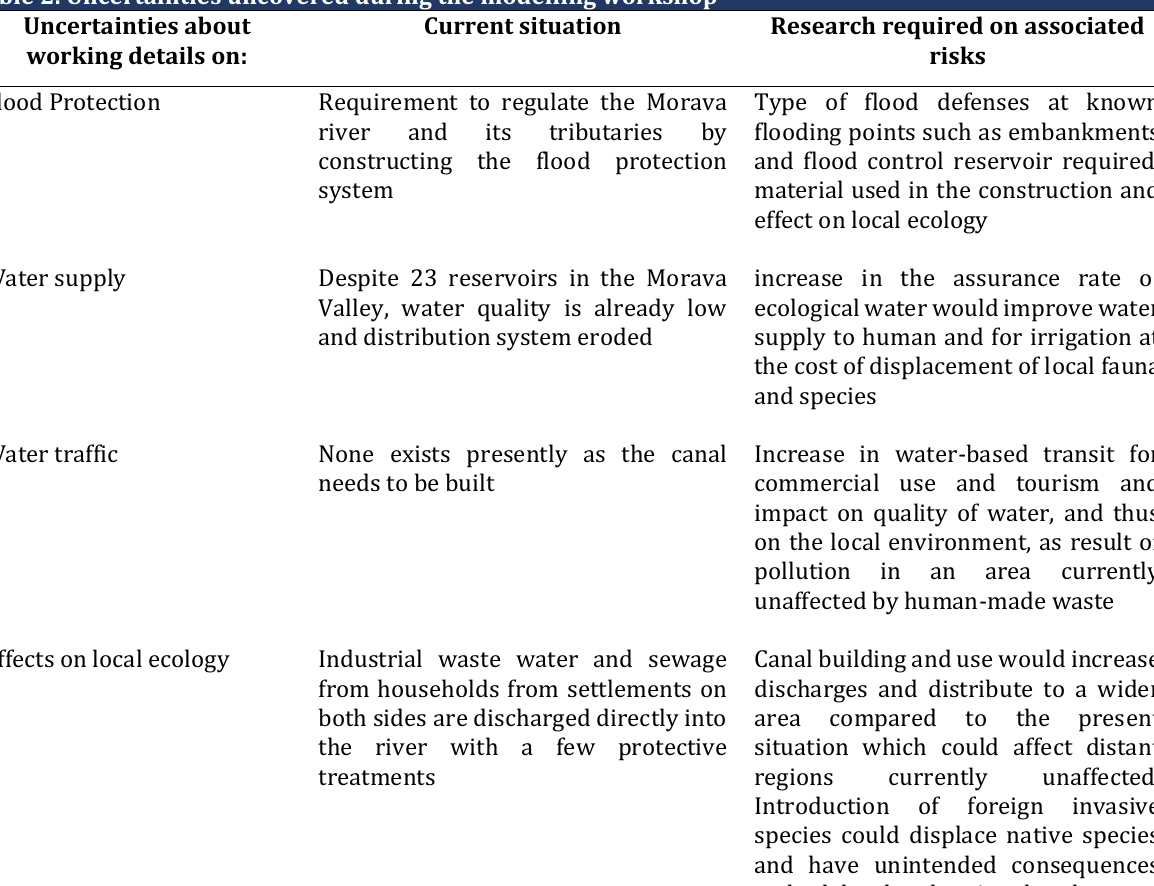
Table 2. Uncertainties uncovered during the modelling workshop Uncertainties